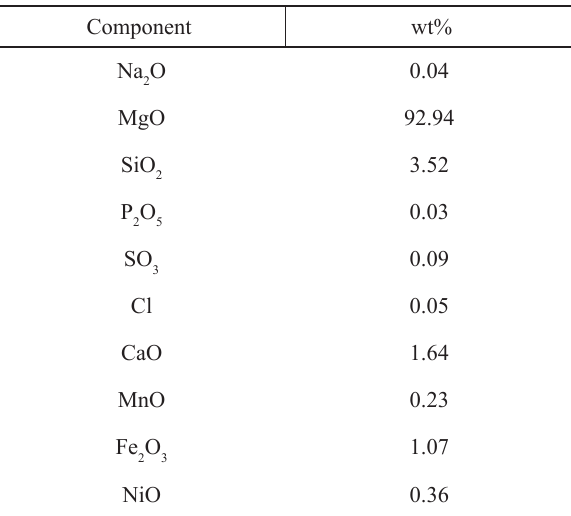
Table 1 – XRF analysis of the natural magnesium carbonate/ oxide from Nehbandan mine Component